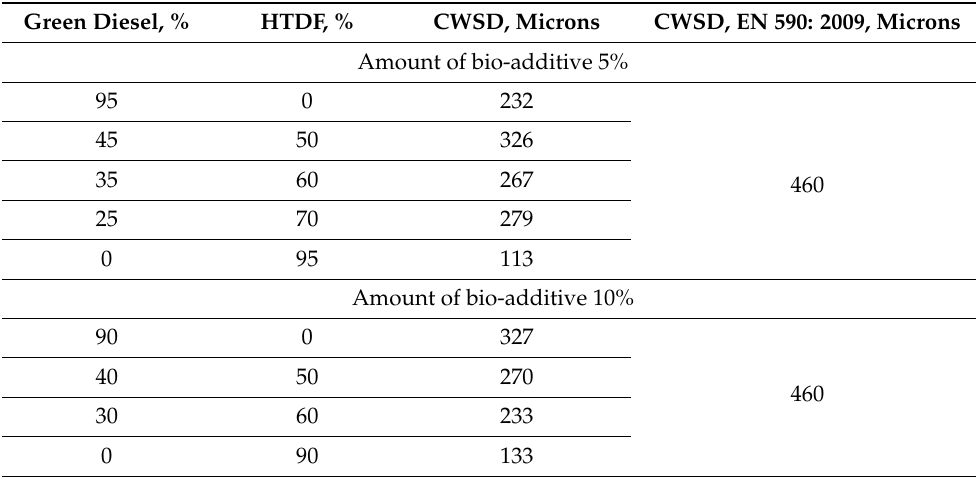
Table 6. Dependence of lubricity on changes in the component composition of mixed fuel with the amount of bio-additive 5% and